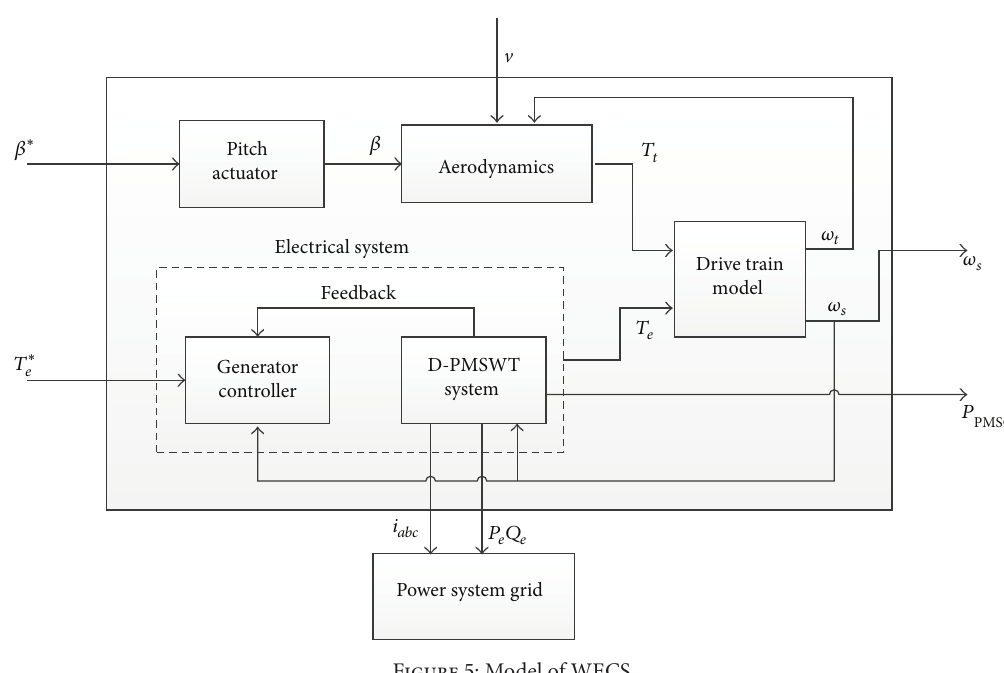
Figure 5: Model of